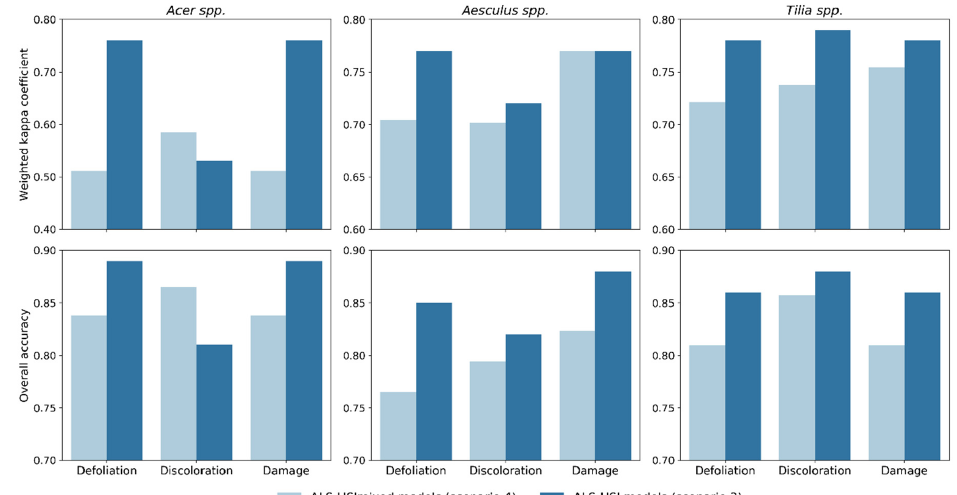
Figure 4. Comparison of tree health classification accuracy for individual species between ALS-HSI models in scenario 3 (models trained and tested for individual tree species using both ALS and HSI indices) and ALS-HSI mixed models in scenario 4 (models trained and tested for mixed tree species using both ALS and HSI indices).